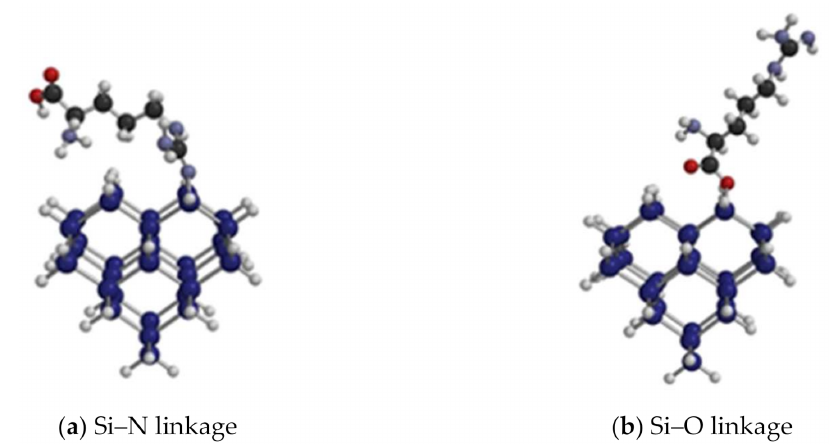
Figure 5. ( a ) Optimized geometry of arginine bound to a Si 32 cluster with an H-terminated Si(001) surface through an Si–N linkage created by attachment through the –NH 2 group with loss of H 2 . This geometry creates an adsorbate with a carboxyl group –COOH at its ω terminus. ( b ) Optimized geometry of arginine bound to a Si 32 cluster with an H-terminated Si(001) surface through an Si–O linkage created by attachment through the –OH group with loss of H 2 . This geometry creates an adsorbate with an amine group –NH 2 at its ω terminus.